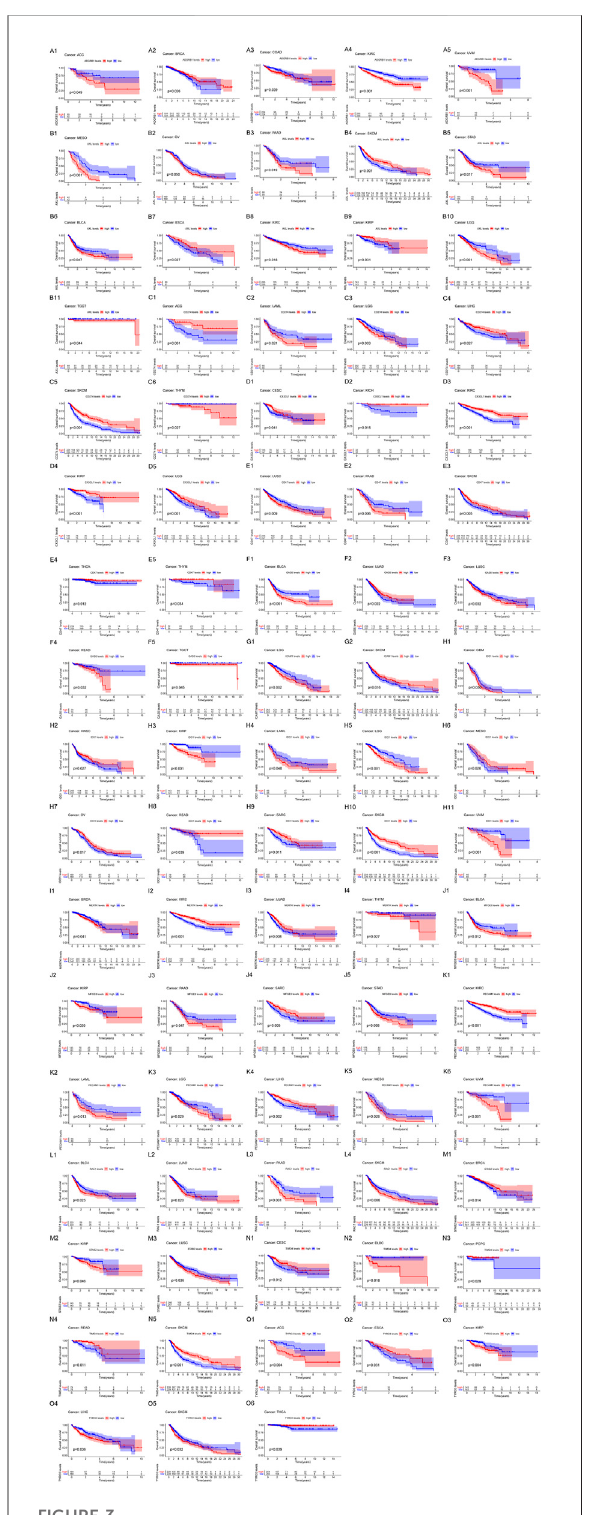
FIGURE 3 The correlation of the expression of efferocytosis-related molecules with the overall survival (OS) in 33 types of cancers. Kaplan-Meier survival curves were generated for the molecules extracted from the comparison of groups of high (red line)